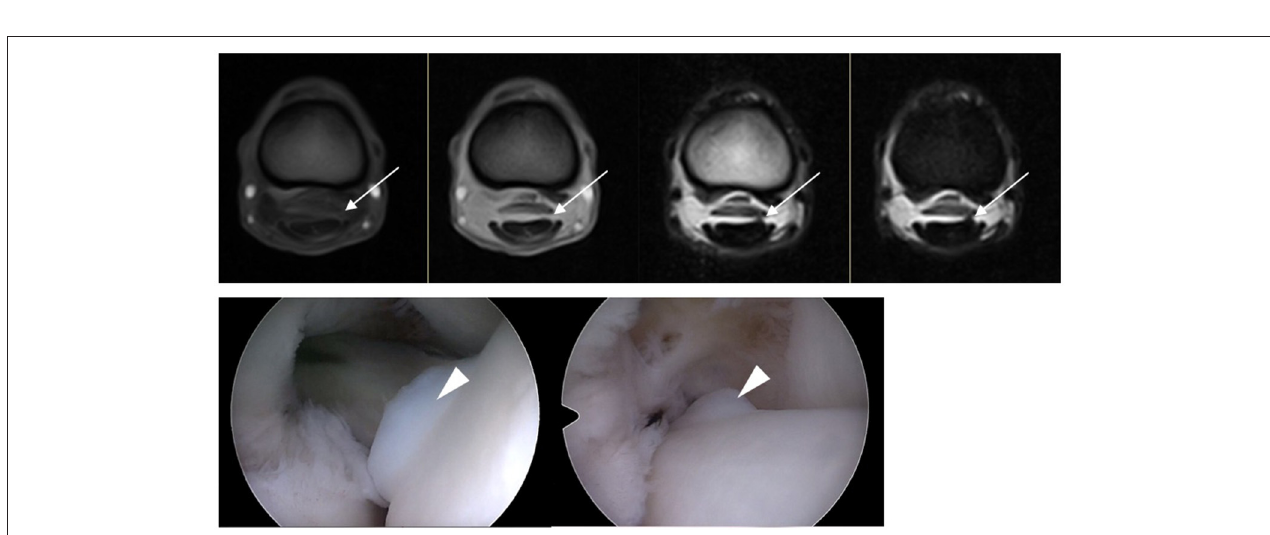
FIGURE 3 | In the top row, from left to right T1W GRE, T2*W GRE, T2W FSE, and STIR FSE images of a dorsolateral DDFT injury at the level of the proximal phalanx where the DDFT goes from ovoid to bilobed in a LF limb (lateral to the right of the image). The injury is clearly evident with low to intermediate SI on T2W FSE and STIR FSE and less well visualized on T1W GRE and T2*W GRE (white arrow). The appearance during tenoscopic examination is shown in the bottom row images (white arrowhead) (tenoscopic images courtesy of Via Nova